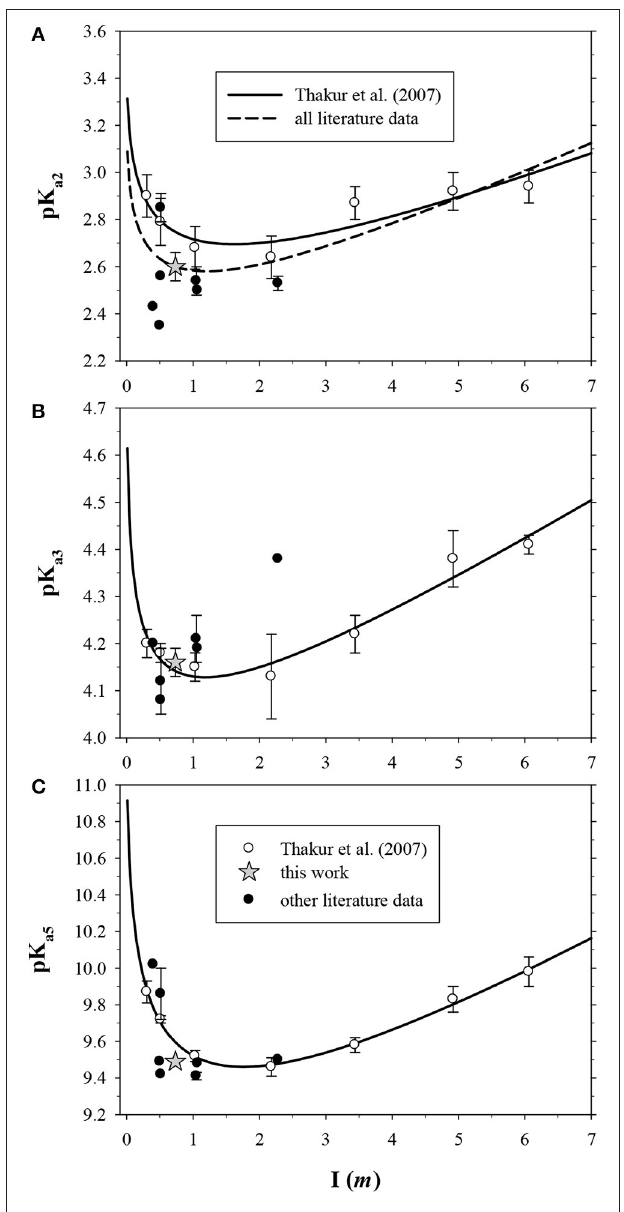
FIGURE 2 | Literature values of three DTPA acid dissociation constants in NaClO 4 solutions as a function of ionic strength ( Table 3 ), converted to molal units. Data from Thakur et al. (2007) were fit with extended Debije-Hückel functions. Error bars were not reported for some studies ( Table 3 ), or are within the size of the symbol. (A) pK a2 . Additional fit of all data does not include the result from the present work. (B) pK a3 . One very low value from Nozaki and Koshiba (1967) is not visible. (C) pK a5 . All vertical axes are slightly offset from zero to show the behavior at low ionic